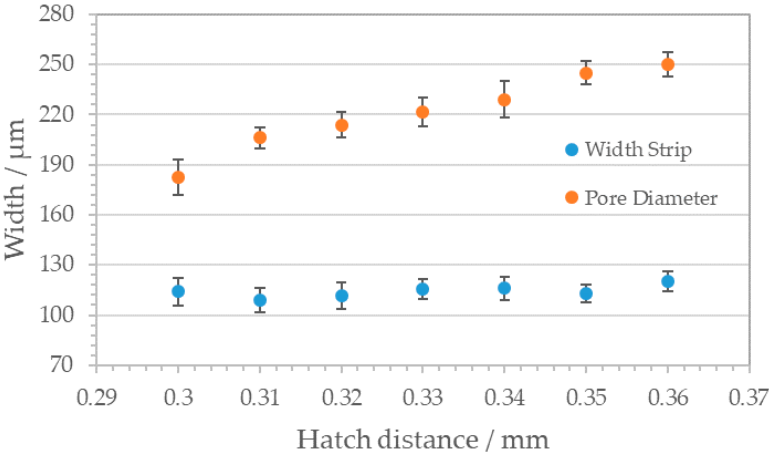
Figure 5. Correlation between hatch distance and resulting pore geometries for square pattern structure. Blue dots, width strip; red dots, pore diameter. With rising hatch distance, the pore diameters increase while the width strip remains constant.